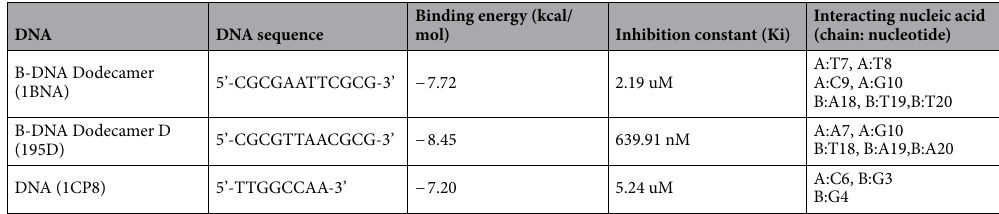
Table 5. Interaction constants of AFM 2 and DNA sequences.